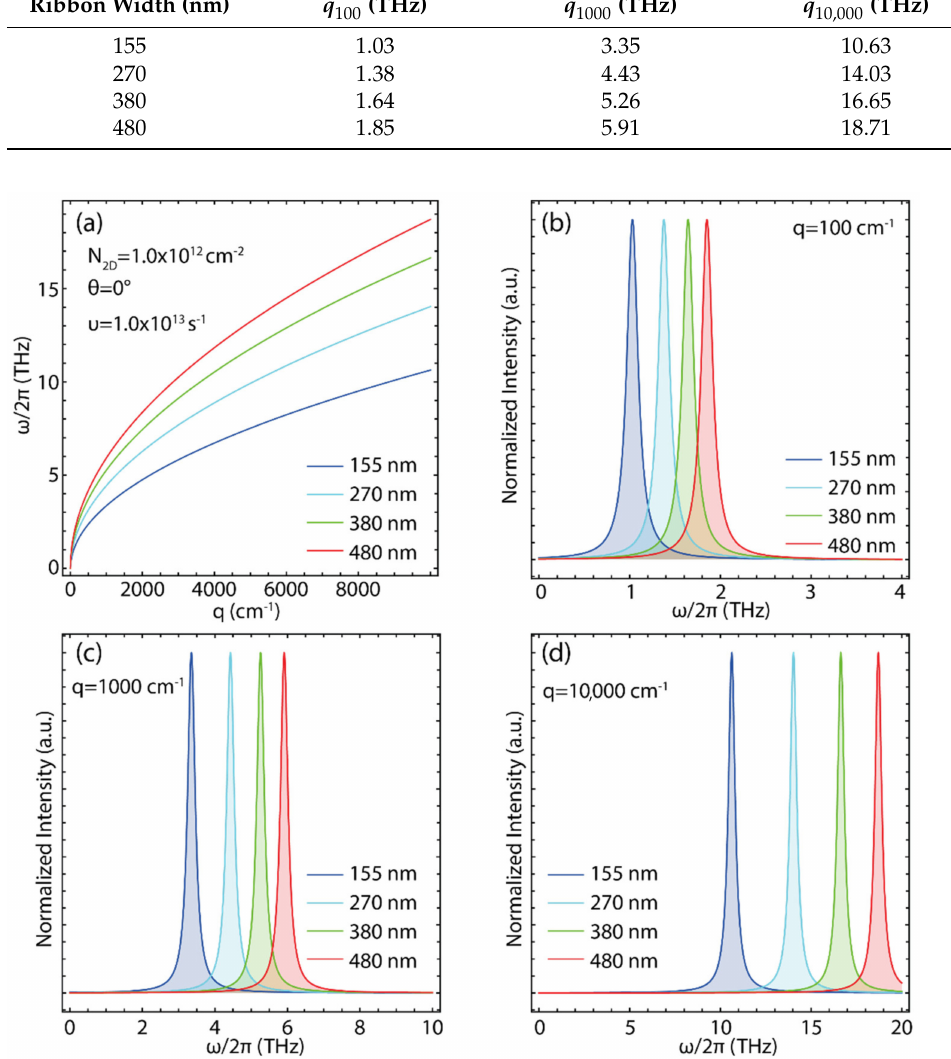
Figure 4. ( a ) Plasmon frequency–momentum dispersion of 2D GNR arrays of interest. ( b ) Maximum of the plasmon peak ( ≤ 4 THz) at q = 100 cm − 1 . ( c ) Maximum of the plasmon peak ( ≤ 10 THz) for at q = 1000 cm − 1 . ( d ) Maximum of the plasmon peak ( ≤ 20 THz) at q = 10,000 cm − 1 . The corresponding transition frequency was taken from Table 2 for the selected q